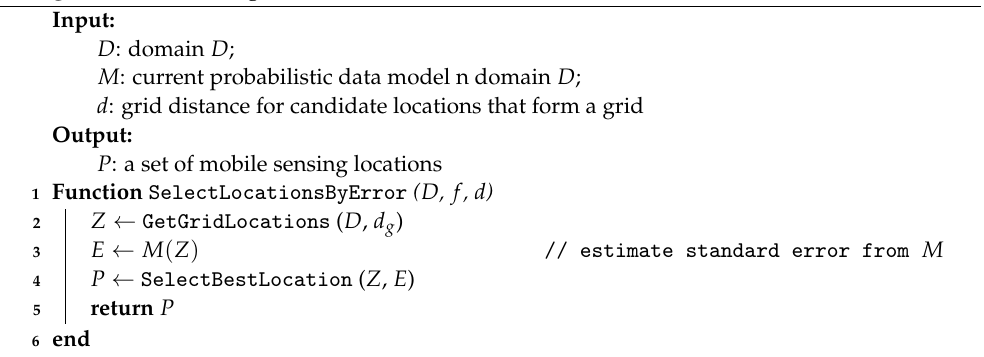
Algorithm 3: Sensing locations selection via standard error